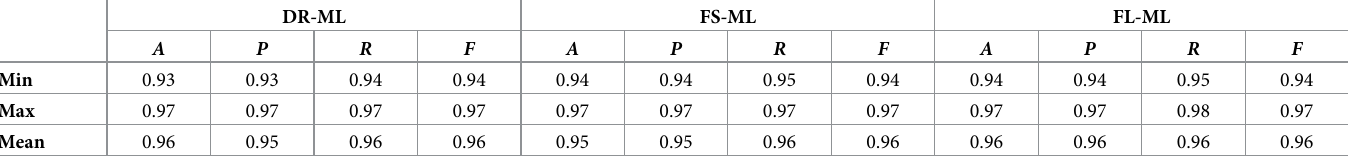
Table 15. Summary of the classification performance of ML learners using features from 11 DCNNs.